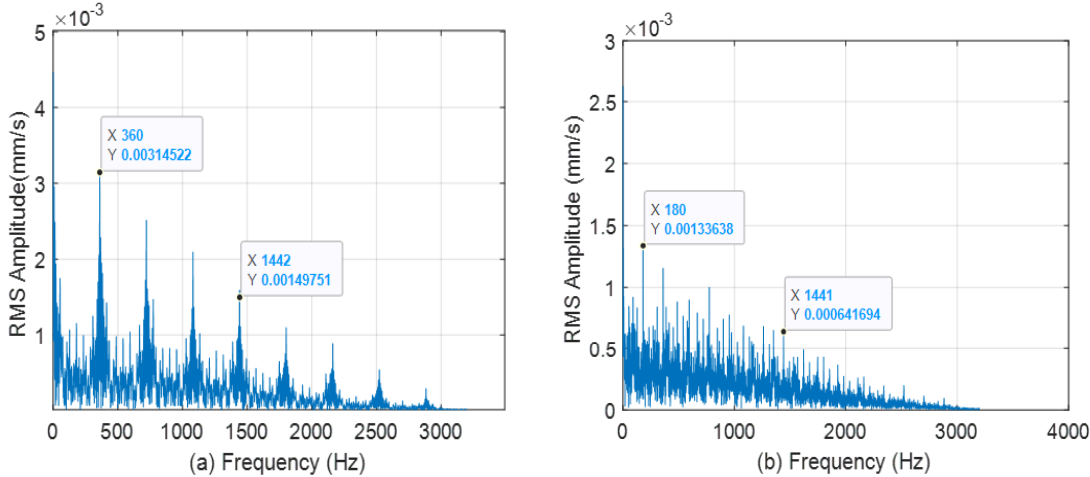
Figure 17. Experimental response of imbalance and rotor-casing rub ( a ) without water and ( b ) with water.